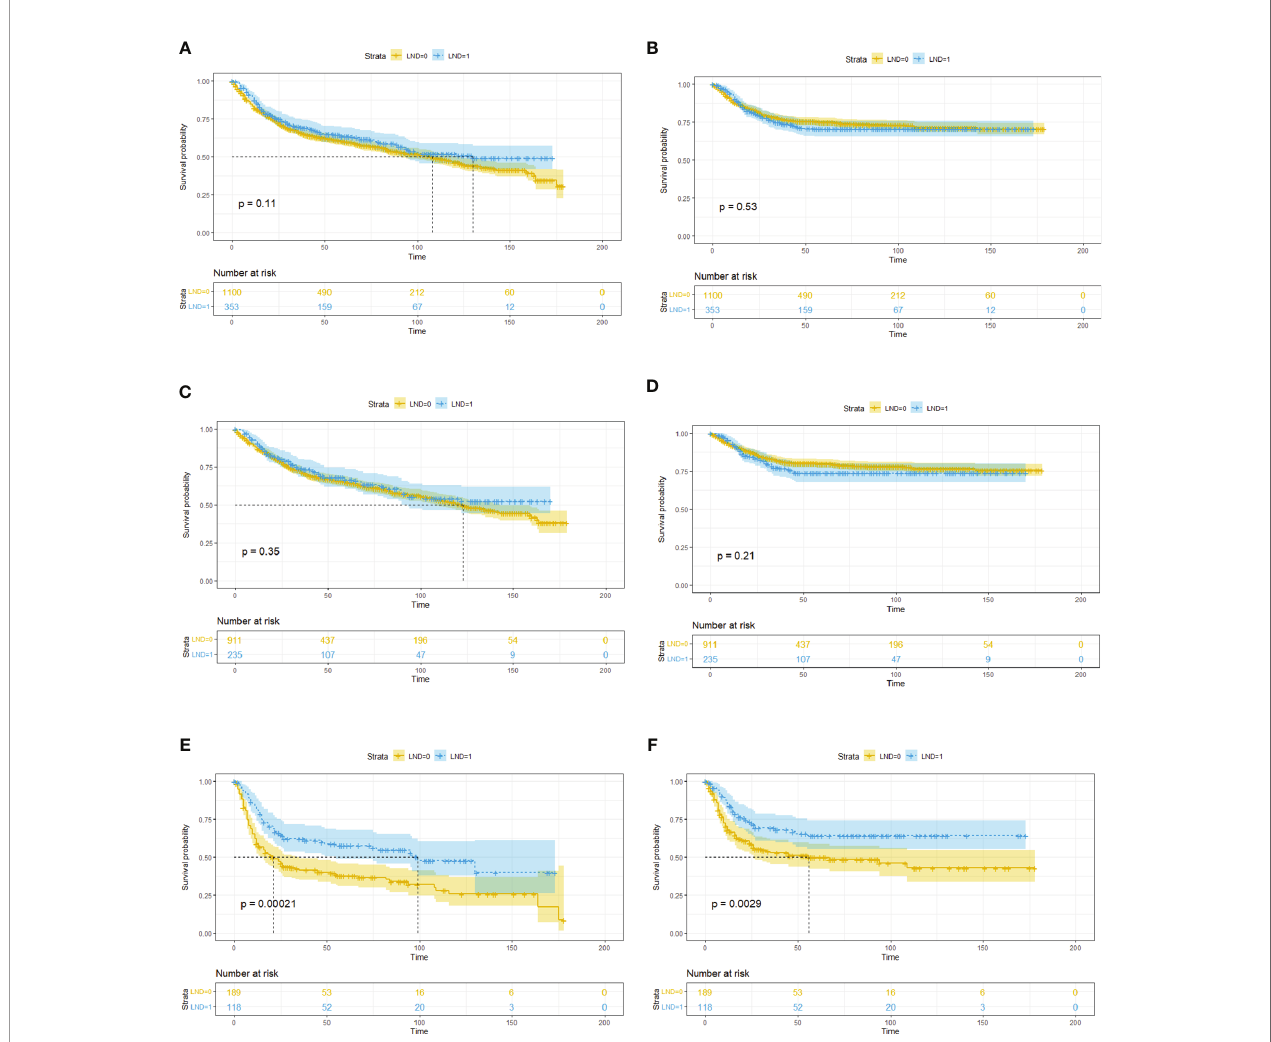
FIGURE 5 | Subgroup Kaplan – Meier survival analysis for LND in the primary SEER penile cancer cohort (patients with positive N stage or M stage were retained). (A) Overall survival for the whole cohort. (B) Cancer-speci fi c survival for the whole cohort. (C) Overall survival in the T1T2 subgroup. (D) Cancer-speci fi c survival in the T1T2 subgroup. (E) Overall survival in the T3T4 subgroup. (F) Cancer-speci fi c survival in the T3T4 subgroup.